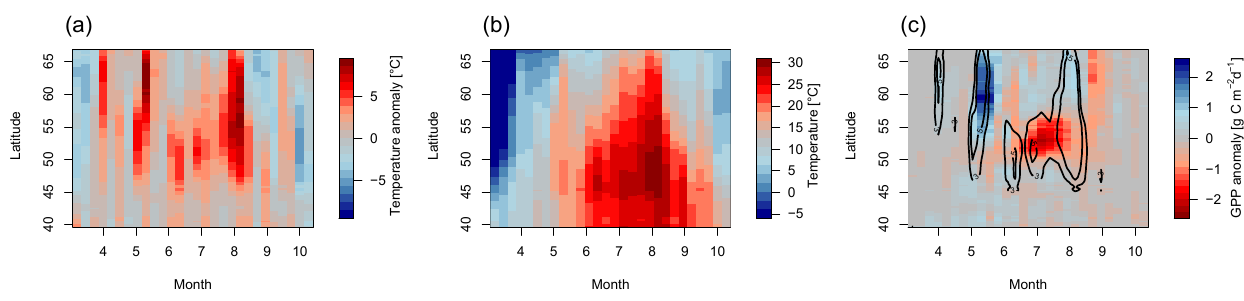
Figure 1. Longitudinal average (30.25 to 60.0 ◦ E) of (a) temperature anomalies (reference period: 2001–2011), (b) absolute temperature, and (c) GPP anomalies in 2010 with a contour of temperature anomalies ( + 3, + 5K).